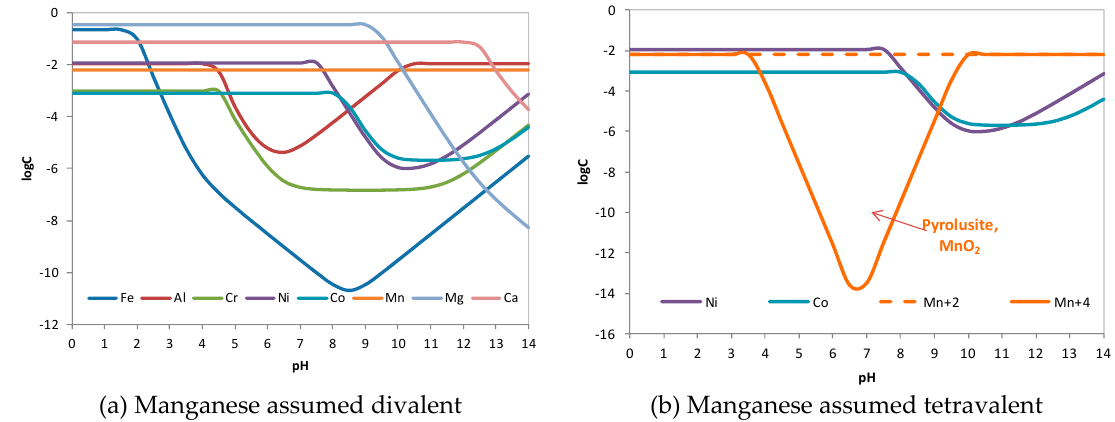
Figure 5. Thermodynamic calculations using Visual Minteq for the identification of optimum pH ranges for the selective precipitation of metals in the form of hydroxides.